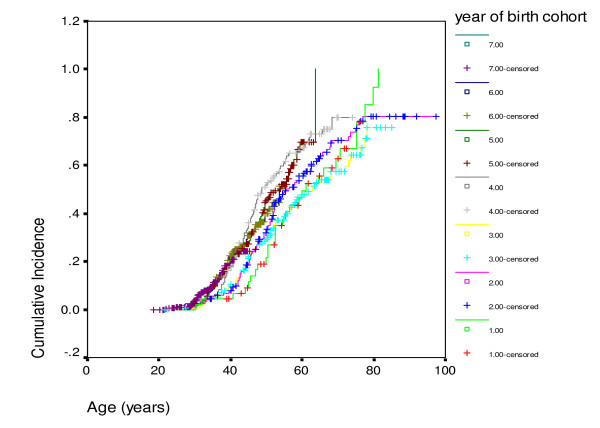
Cumulative risk of breast cancer by age cohort for BRCA1 and BRCA2 combined after exclusion of the index case. Risk to 40 years: Group 1 (birth year <1900; n = 45) 4%; Group 2 (1900–1920; n = 154) 8%; Group 3 (1920–1930; n = 154) 10%; Group 4 (1930–1940; n = 124) 17%; Group 5 (1940–1950; n = 162) 21%; Group 6 (1950–1960; n = 265) 23%; Group 7 (1960+; n = 276) 22%. Log rank (df 6) 153; p = 0.0005.